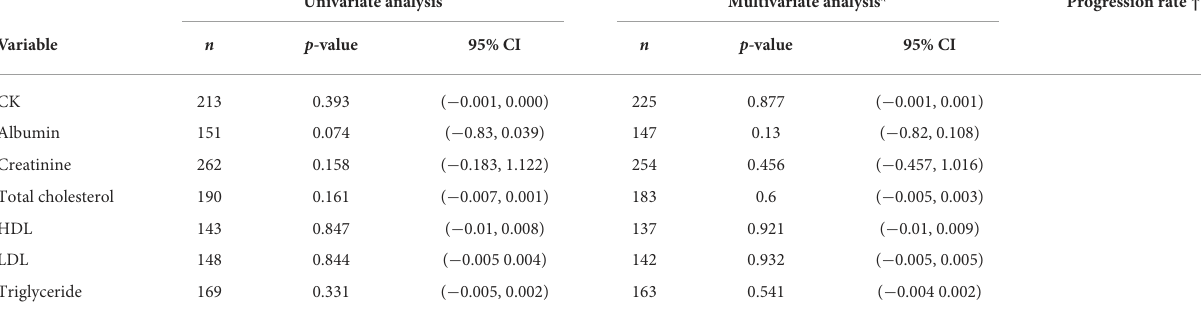
TABLE 4 Linear regression models for progression rate and blood parameters. Univariateanalysis Multivariate